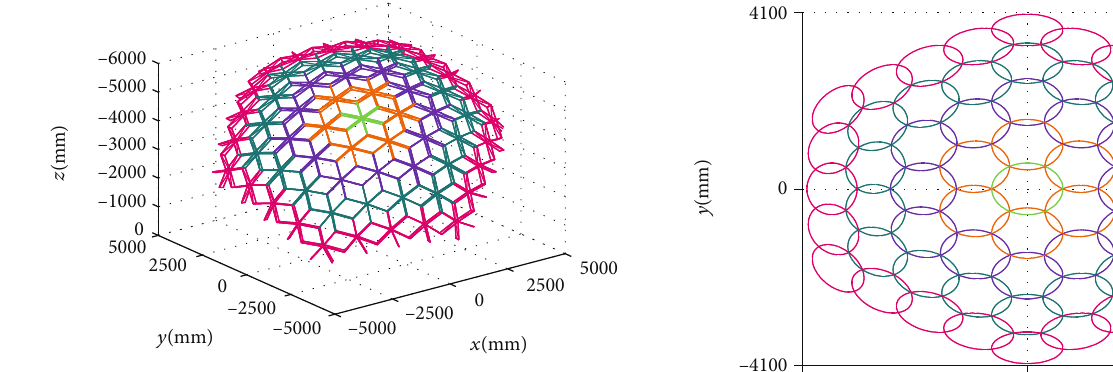
Figure 15: Structural networking model of a modular deployable antenna. Figure 16, the size of the envelope circle model in the y -axis direction is larger than that in the x -axis direction; hence, the envelope circle in the y -axis direction will reach the hemisphere fi rst. Focus on the fi ve envelope circles in the positive y -axis direction of Figure 16. The midpoints of the chord intersect- ing envelope circles 1 and 12 are M 1 , and the midpoints of the chord intersecting envelope circles 12 and 14 are M 2 , as shown in Figure 17.